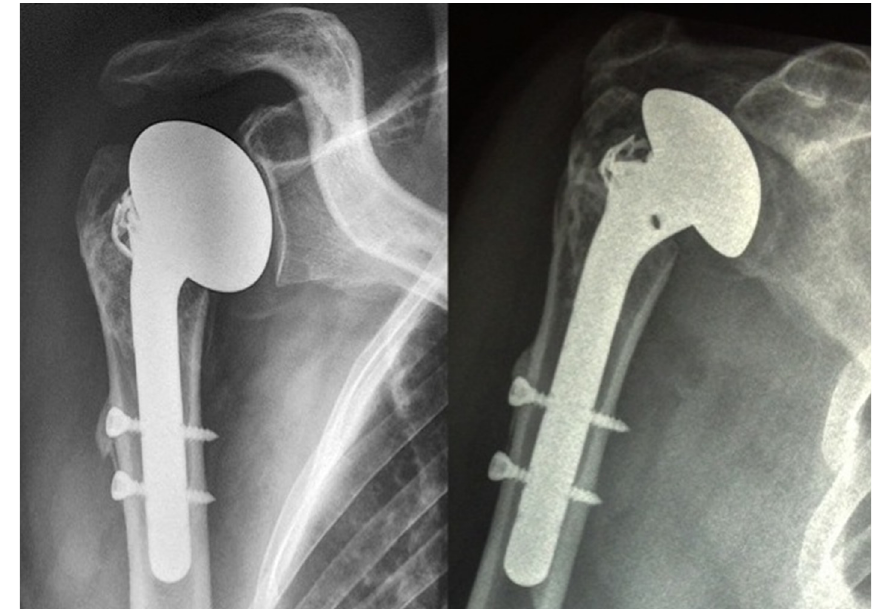
Figure 7. Bone union on X-ray at same